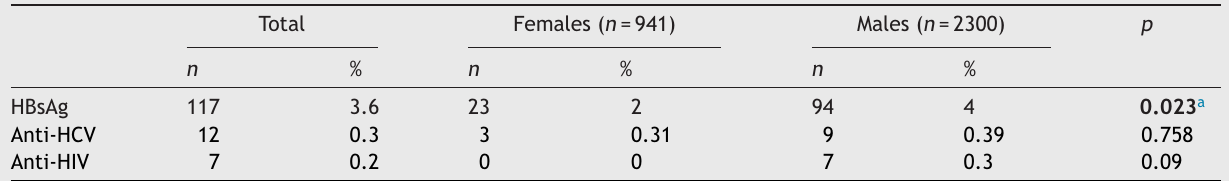
Serological data for HBsAg, anti-HCV, and anti-HIV. Total Females ( n =